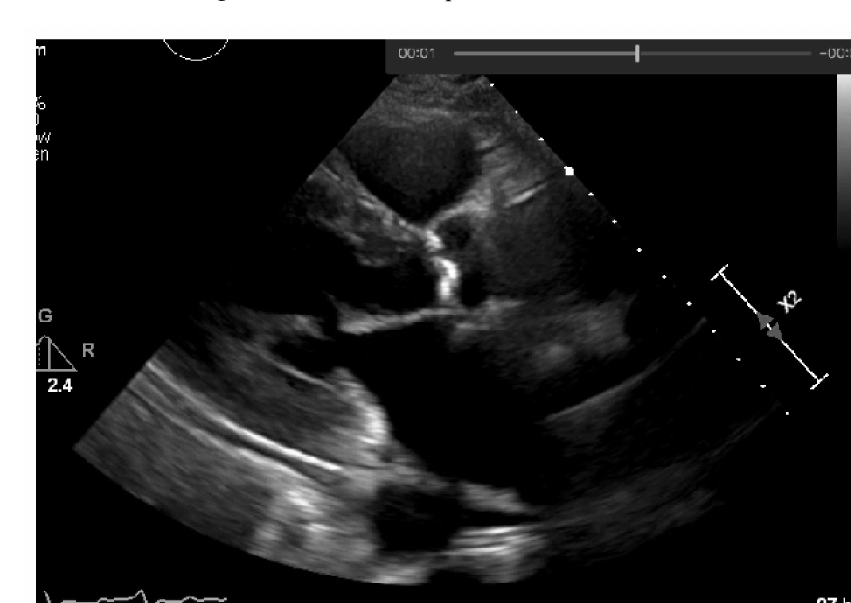
Figure 15. Image loaded in